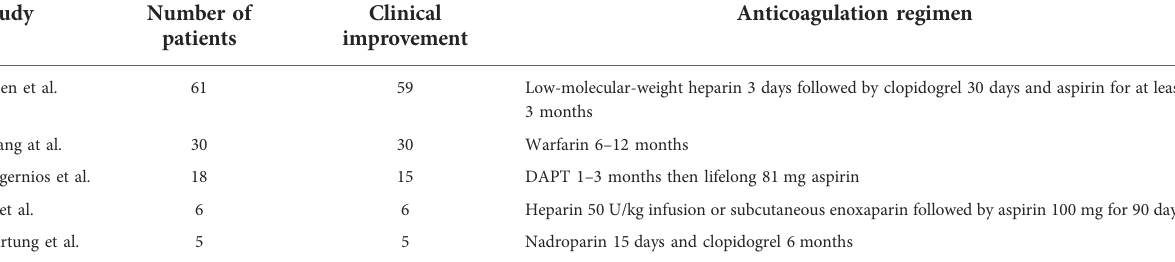
TABLE 1 Partial or complete improvement of symptoms and anticoagulant regimen according to study.